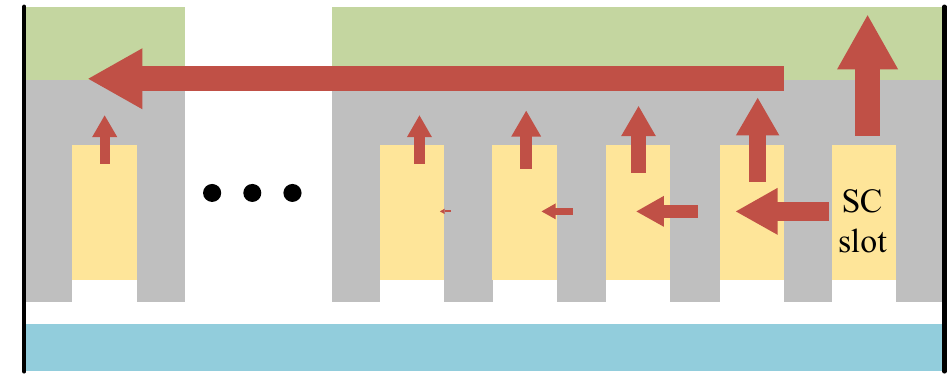
Figure 12. Simplified LPTN model.